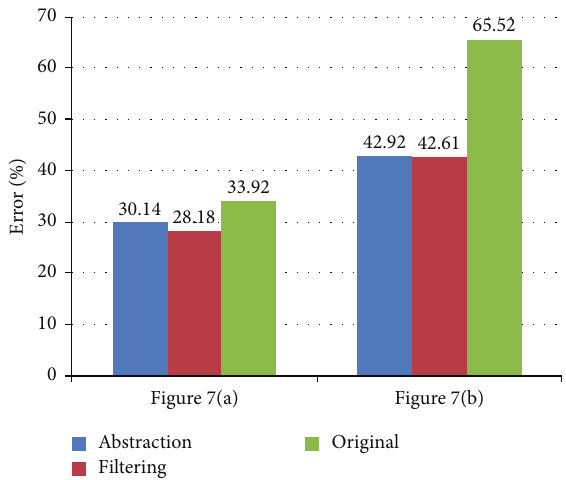
Figure 8: Error rates of image segmentation by fuzzy 𝑐 -means